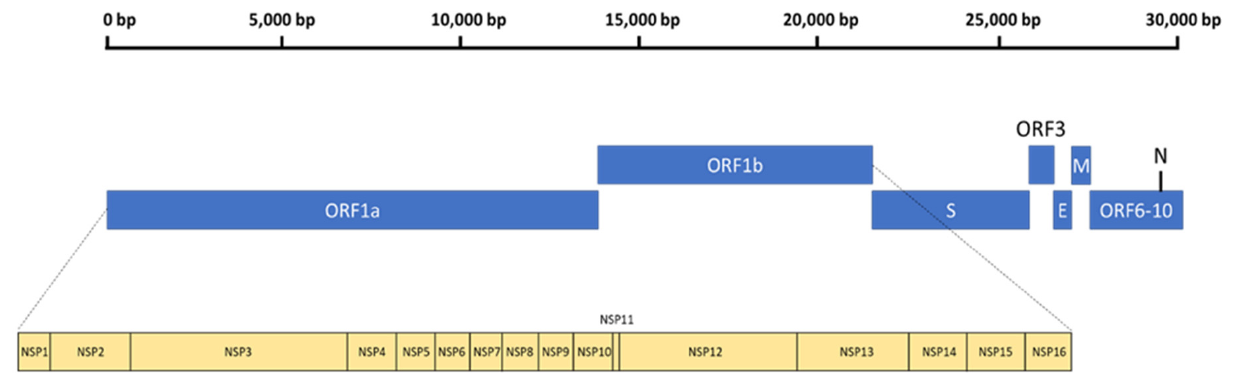
Figure 1. The general genomic organization of SARS-CoV-2.